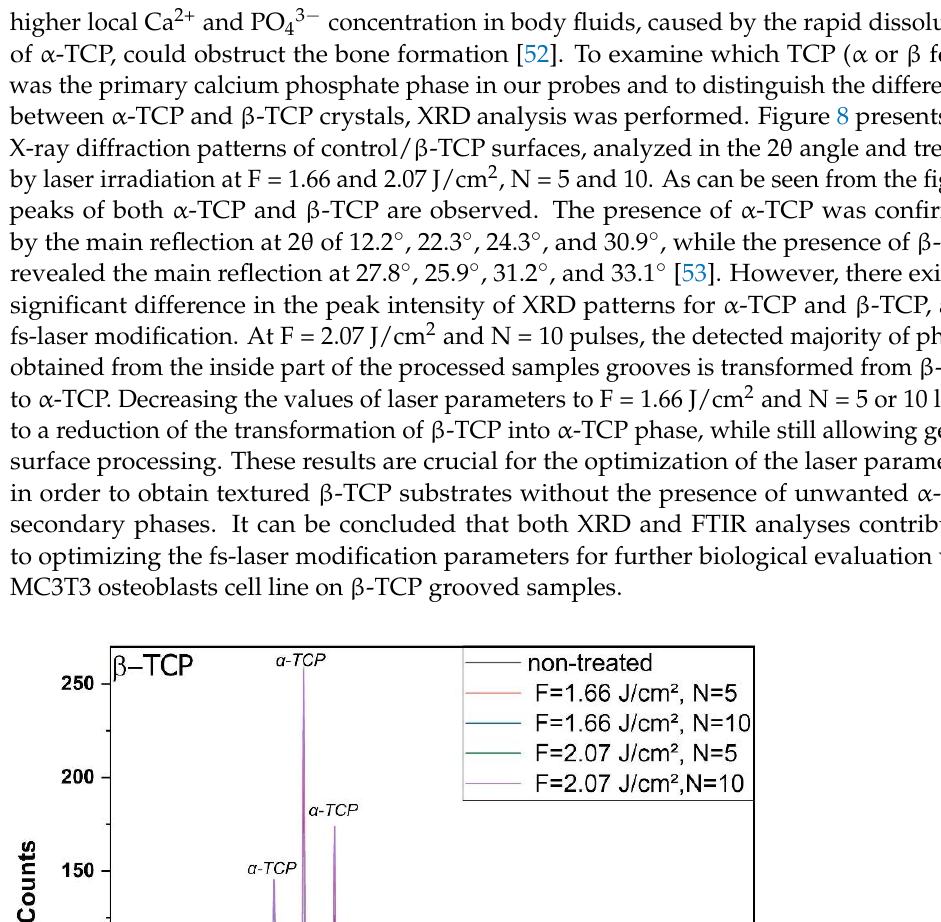
Table 2. Parameters employed for texturing in two different regimes of femtosecond laser patterning.